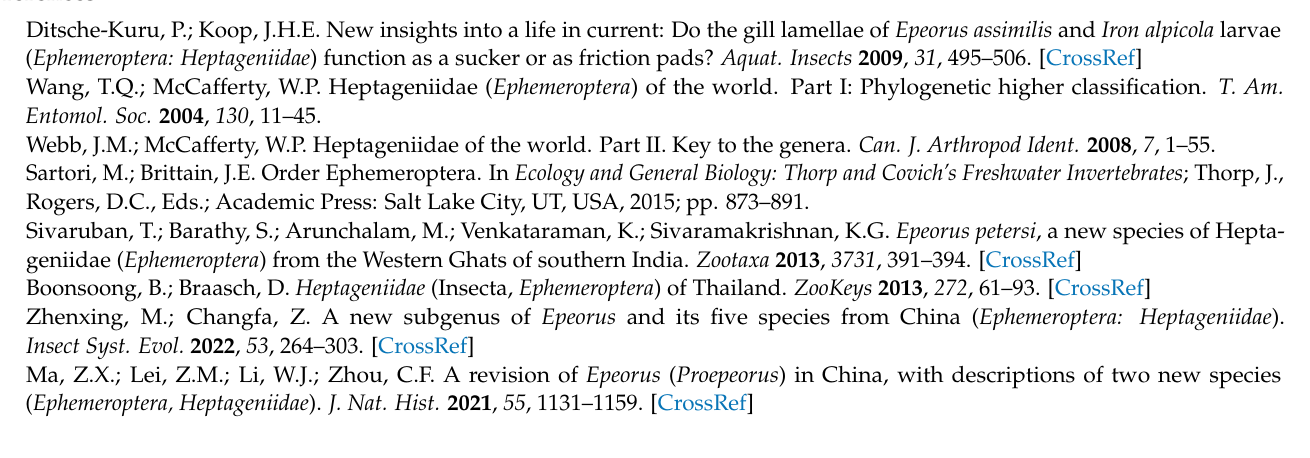
Table S6: Partition schemes and best-fitting models selected in PCG dataset; Table S7: Partition schemes and best-fitting models selected in PR